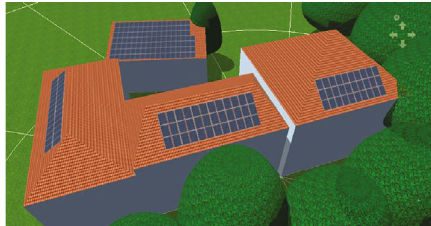
Figure 15: Architectural from top view at the project site (BAPV system design for E6+E8 Buildings).